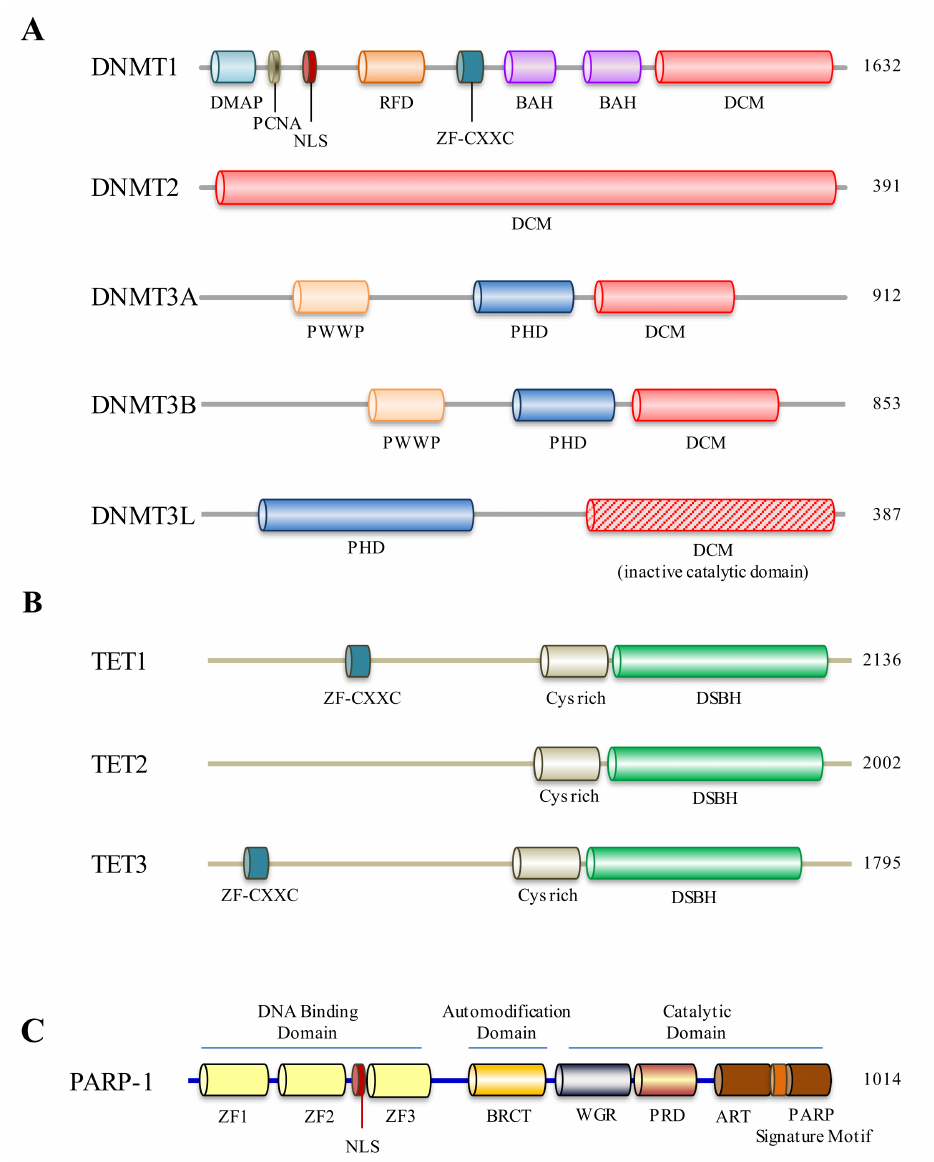
Figure 2. Schematic structure of human DNMT, DNMT3-like, TET family and PARP1 proteins. ( A ) DMAP, DMAP1-binding domain; PCNA, Proliferating Cell Nuclear Antigen domain; NLS, Nu- clear Localization Signal domain; DNMT1-RFD, Cytosine-specific DNA methyltransferase replication foci domain; Zf-CXXC, CXXC zinc finger domain; BAH, Bromo adjacent homology domain; DCM, DNA-cytosine methylase; Cyt_C5_DNA_methylase, Cytosine-C5 specific DNA methylases; PWWP, domain comprising a conserved proline–tryptophan–tryptophan–proline motif; PHD, plant home- odomain; The sequences are derived from data reported under accession numbers NP_001124295 for DNMT1, NP_004403 for DNMT2, NP_783328 for DNMT3A, NP_008823 for DNMT3B and NP_037501 for DNMT3L. ( B ) Domain structures of ten–eleven translocation methylcytosine dioxygenases (TETs). Schematic representation of conserved domains of human TET proteins is shown, including a double- stranded-helix (DSBH) fold (all TETs), cysteine-rich (Cys-rich) domain (all TETs) and CXXC zinc fingers (Zf-CXXC; in TET1 and TET3). The sequences are derived from data reported under accession numbers NP_085128 for TET1, NP_001120680 for TET2 and NP_001274420 for TET3. ( C ) Domain structure of PARP1. PARP1 has four main domains, an amino (N)-terminal DNA-binding domain, an auto-modification domain, a water-binding domain and a carboxy (C)-terminal catalytic domain. ZFI, zinc finger I; ZF2, zinc finger II; ZF3, zinc finger III; NLS, nuclear localization signal; BRCT, BRCA1 C-terminal domain; PRD, PARP regulatory domain; ART, ADP-ribosyl transferase